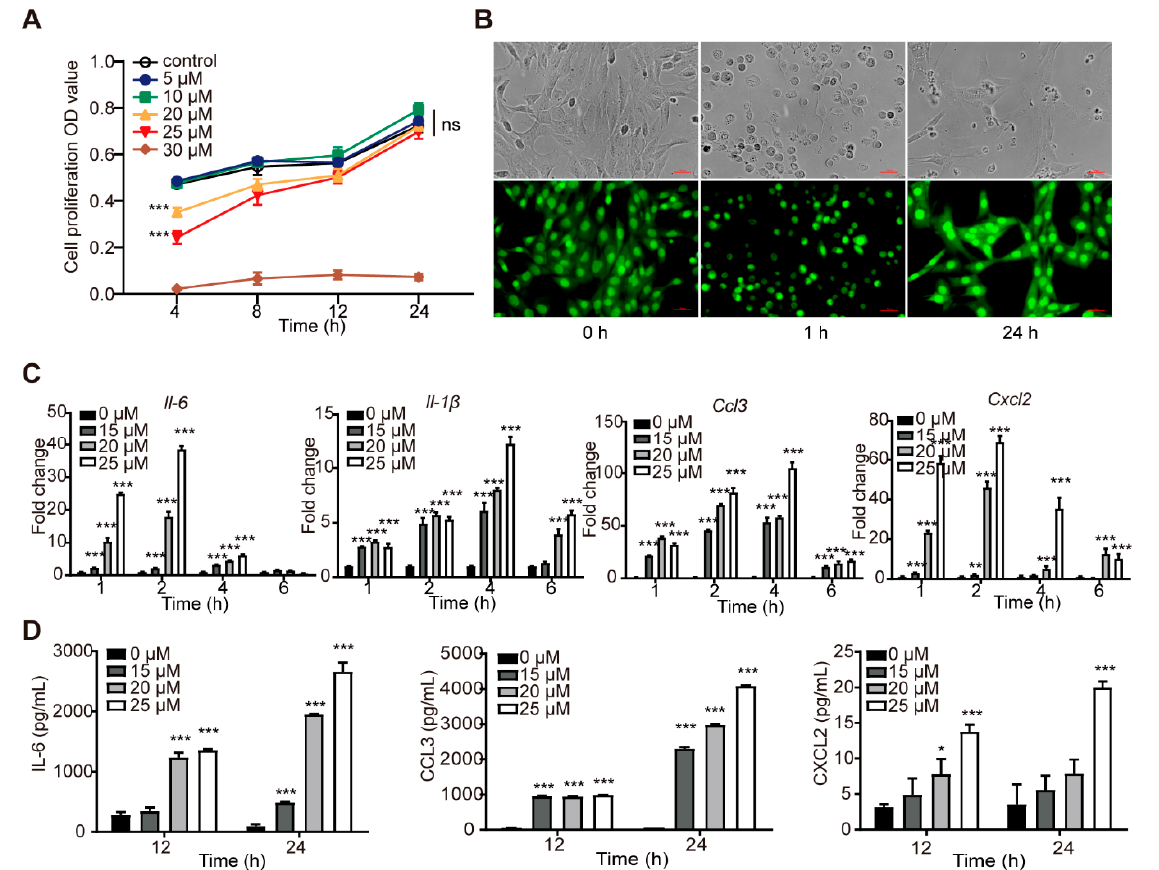
Figure 2. PD-induced transient cytotoxicity and inflammatory response in C2C12 cells. ( A ) Cell viability assay by MTT method. ( B) Microscopic pictures of optical cell morphology showing the cytotoxicity of PD (25 μ M) towards C2C12 cells by AO staining. ( C ) The gene expression of Il-6 , Il-1 β , Ccl3 , and Cxcl2 in C2C12 cells by RT-qPCR. ( D ) The levels of IL-6, CCL3, and CXCL2 in the culture supernatants of C2C12 cells by ELISA. Data were presented as mean ± SD ( n = 3). (*) p < 0.05, (**) p < 0.01, (***) p < 0.001, ns not significant.